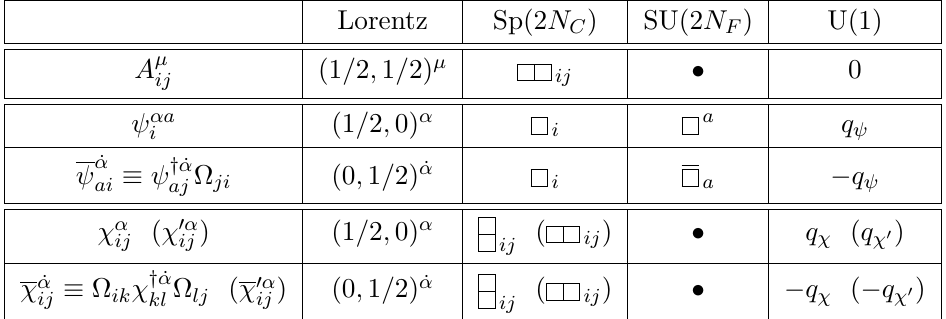
Table 1 . The constituent fields of the HC theory: the gauge bosons A , the Weyl fermions ψ and χ (or χ 0 ) and their conjugates. In our convention i, j, . . . are Sp(2 N C ) indexes, µ, ν, . . . Lorentz vector indexes, α, β . . . and ˙ α, ˙ β, . . . Lorentz spinor indexes, a, b, . . . flavour SU(2 N F ) indexes. Singlets are indicated by a bullet. The ratio of U(1) charges is determined by the requirement of a